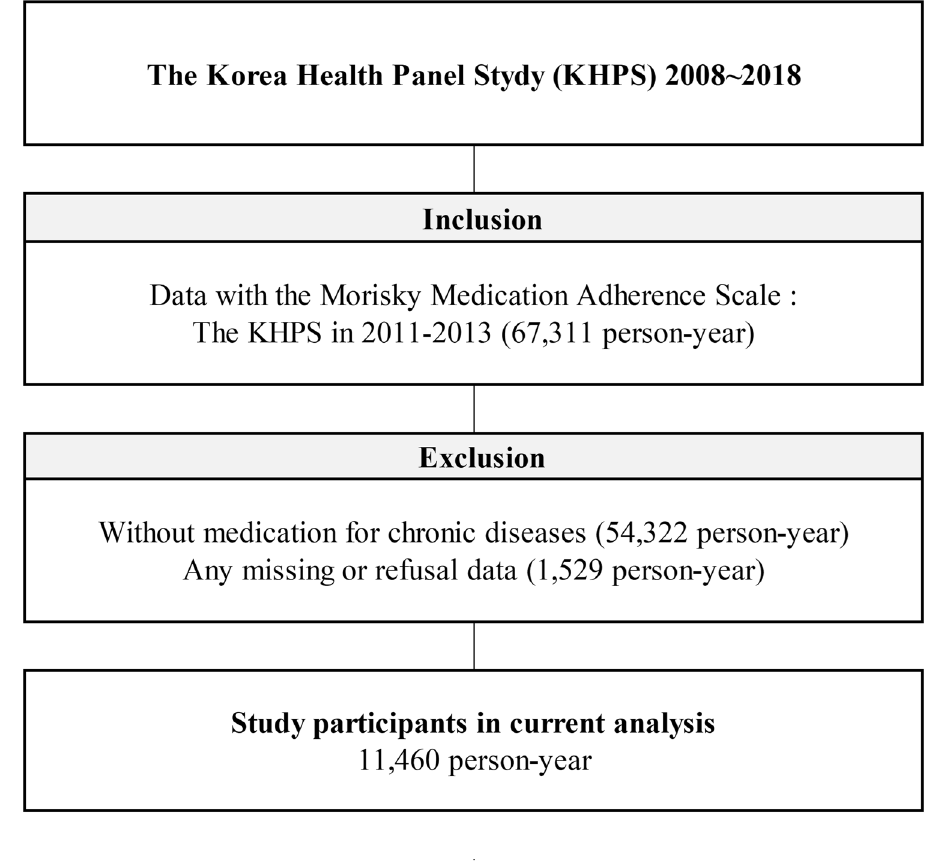
Figure 1. Schematic diagram depicting study